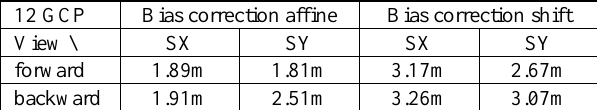
Table 1. Standard deviations of ZY-3 GCP based on RPC- image orientations improved by bias correction with affine